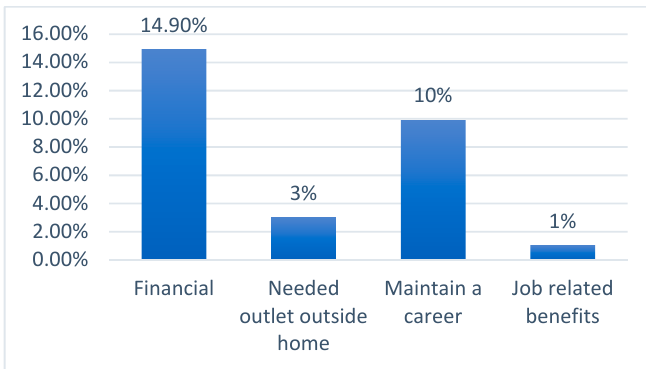
Figure 1. Reasons for going back to work.